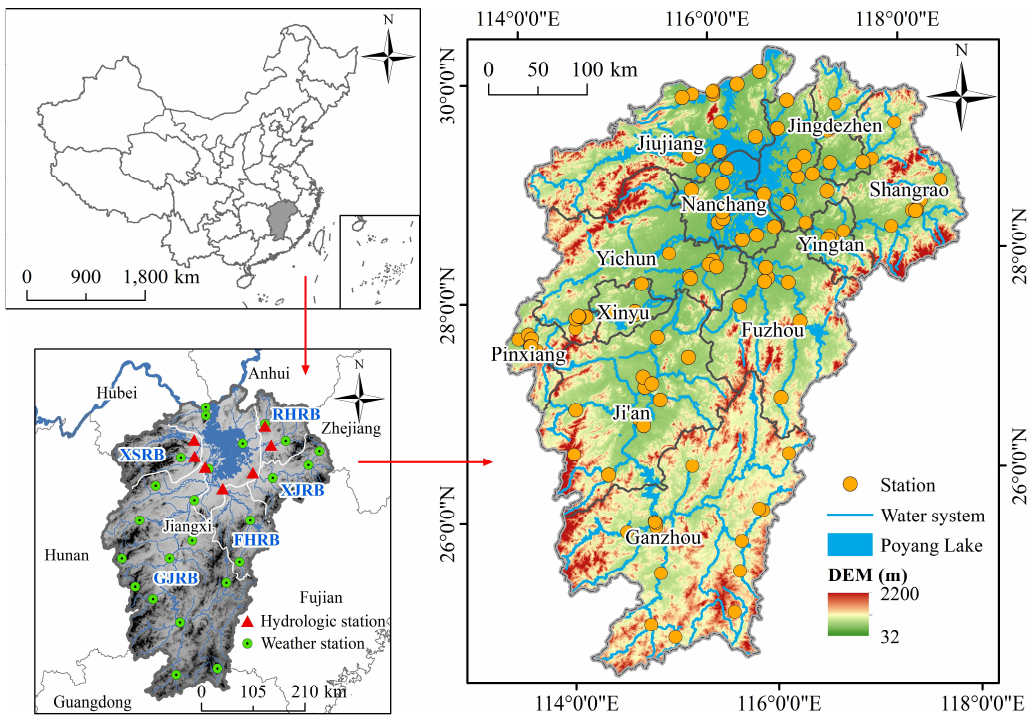
Figure 2. Overview of the Poyang Lake Basin (PLB). Abbreviations, GJRB: Ganjiang River Basin; FHRB, Fuhe River Basin; XJRB: Xinjiang River Basin; RHRB: Raohe River Basin; XSRB: Xiushui River Basin.